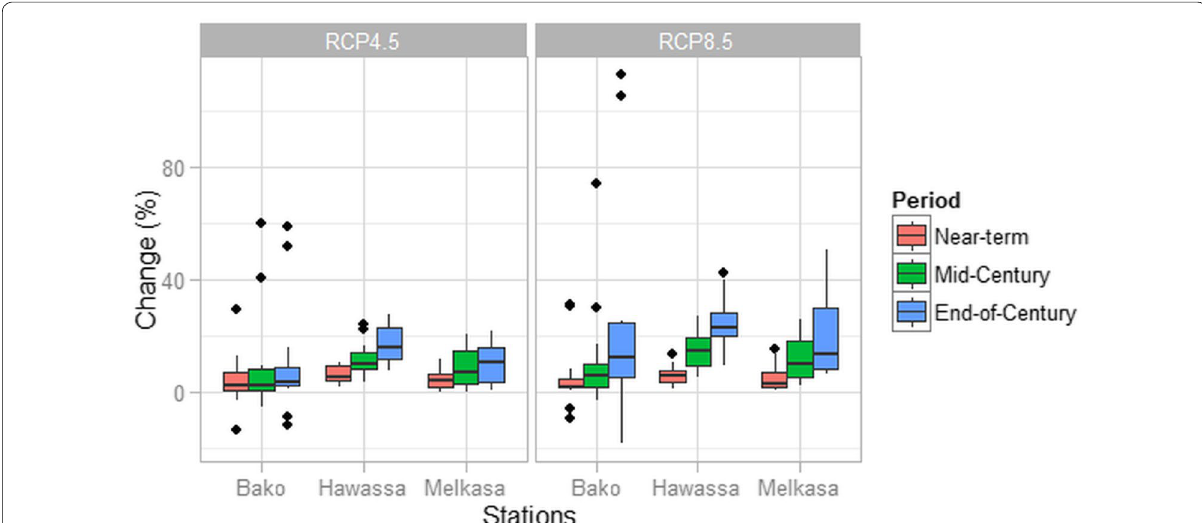
Fig. 4 Monthly rainfall changes (% of baseline) for two RCP4.5 (left) and RCP8.5 (right), per station and per future time periods (near term, mid and end of century)